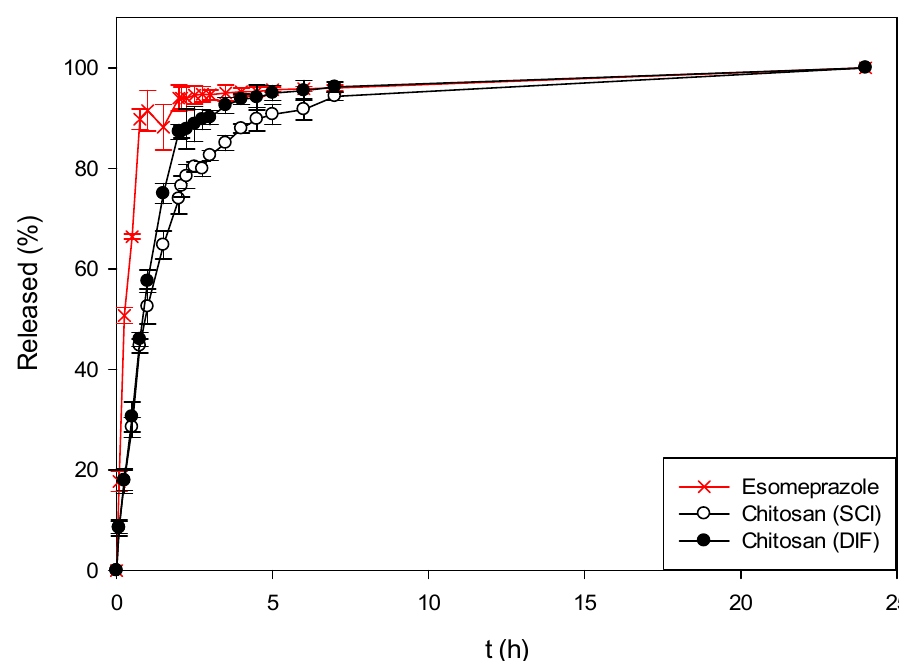
Figure 8. Dissolution profiles of pure esomeprazole and esomeprazole impregnated into chitosan aerogels using both impregnation techniques.